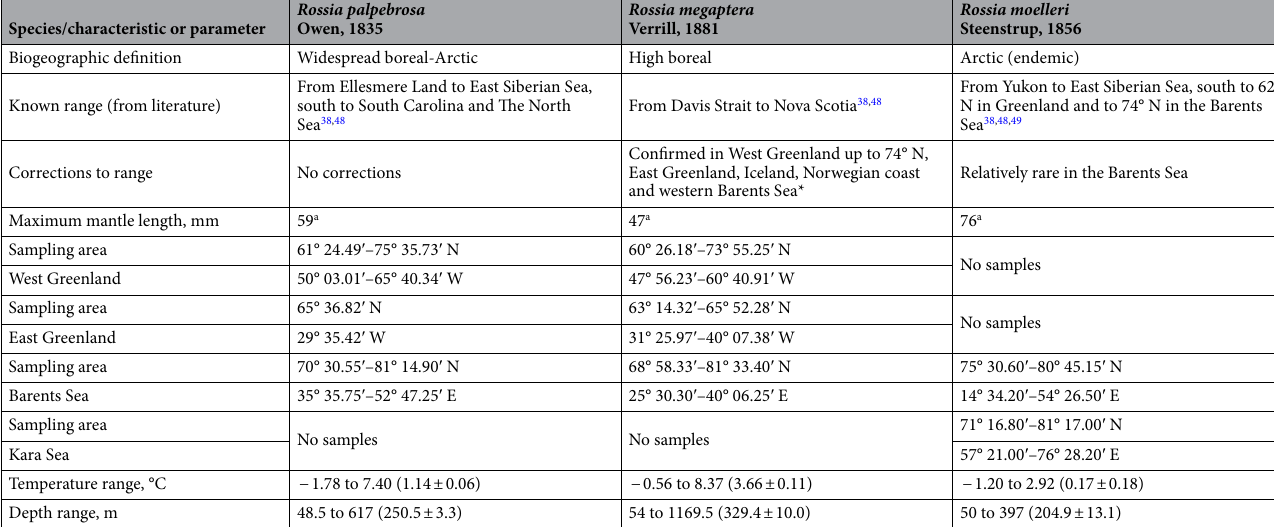
Table 1. Ranges and maximum recorded sizes in the studied species of the genus Rossia , and exact sampling areas and corresponding environmental parameters (temperature and depth). Values of environmental parameters are minimum − maximum (mean ± SE). *Reasons why R. megaptera was overlooked for a long time on such huge areas and related details are work in progress (Golikov et al. in prep.). Presence of this species in Iceland was recently published 50 . a New maximum mantle length of these species, exciding previous published records (cf. 38,48,49,51